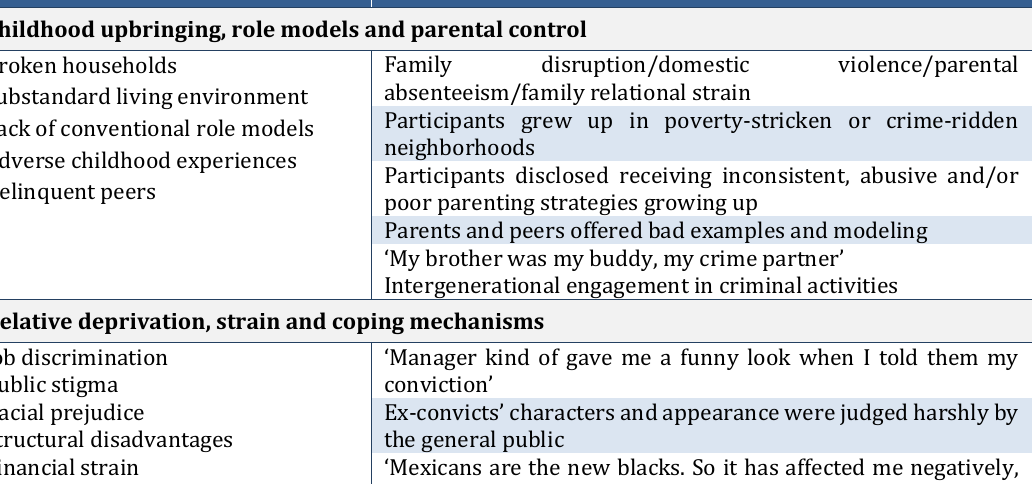
Table 1: Categories, subcategories, themes and illustrative text Sub ‐